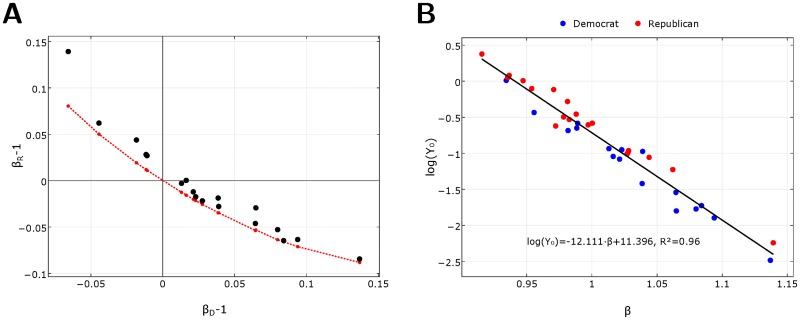
Interrelation of the parameters of urban scaling in US elections.A Urban scaling exponents of Republicans as a function of the Democrats for 18 US presidential elections from 1948 to 2016 (dots) and the theoretical curve (red line) derived from probability conservation (5). B Intercepts of the scaling relations log Y0 as a function of the scaling exponent β for Republicans (red) and Democrats (blue) for presidential elections in the period 1948–2016. Fitted line (3) with parameters and regression coefficient in the inset.